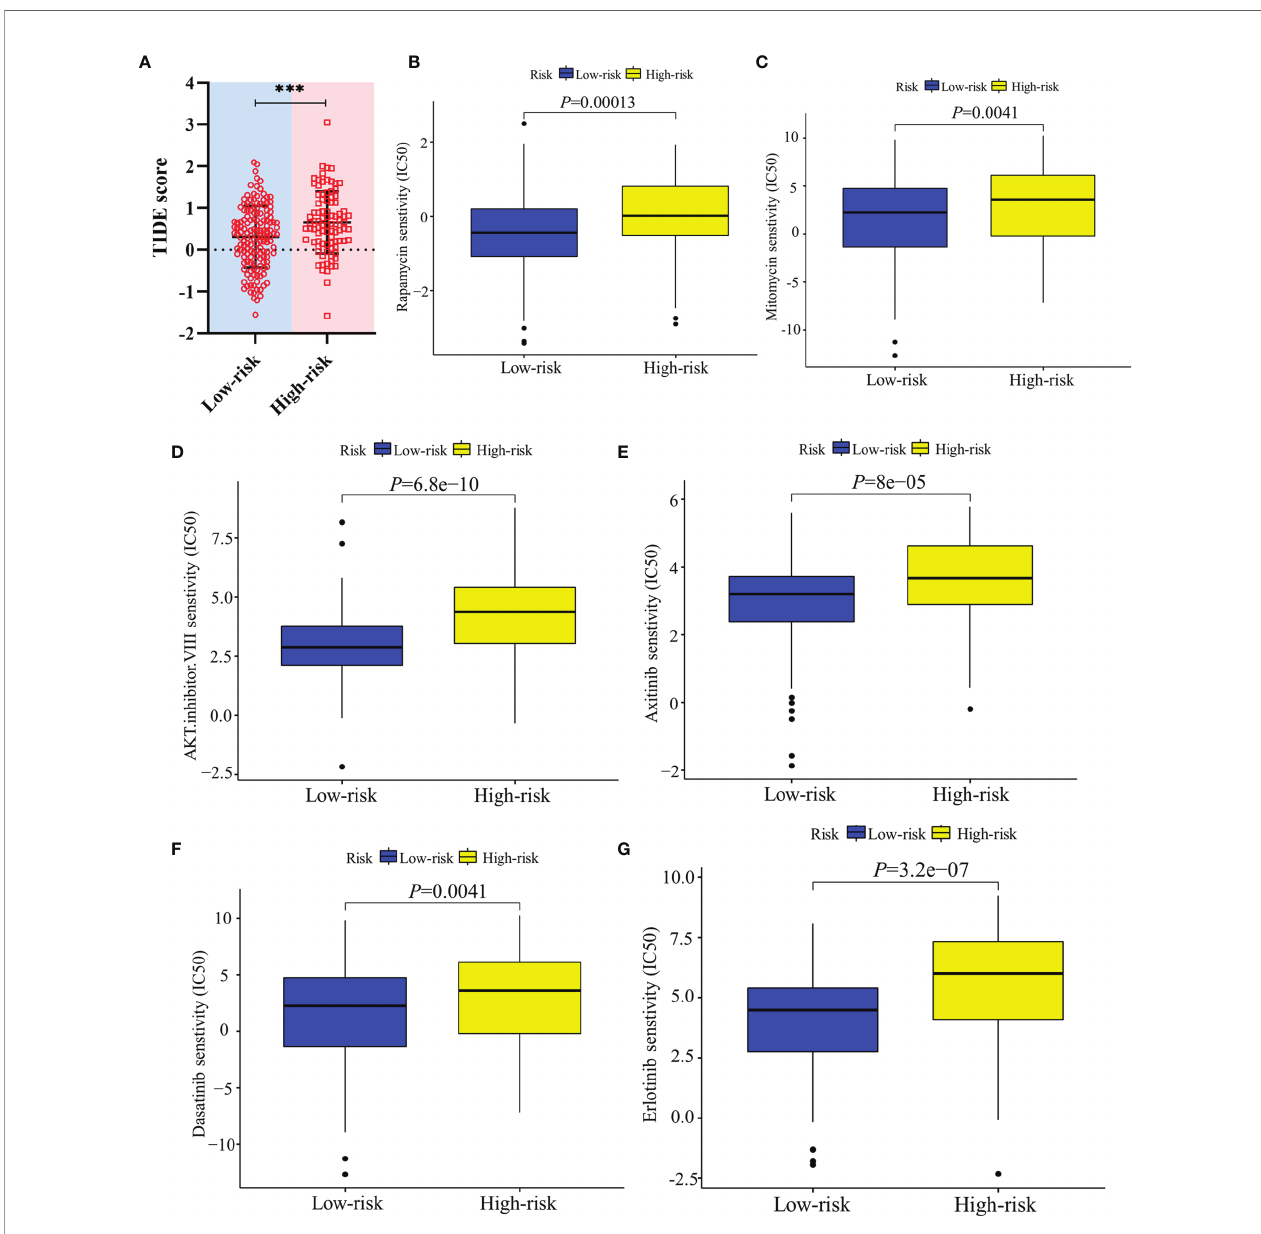
FIGURE 8 | Validation of the therapeutic response in the ICGC cohort. (A) TIDE scores of high-risk and low-risk groups in the ICGC cohort. (B – G) Sensitivity of high-risk and low-risk groups of the ICGC cohort to drug therapy. ***: P <